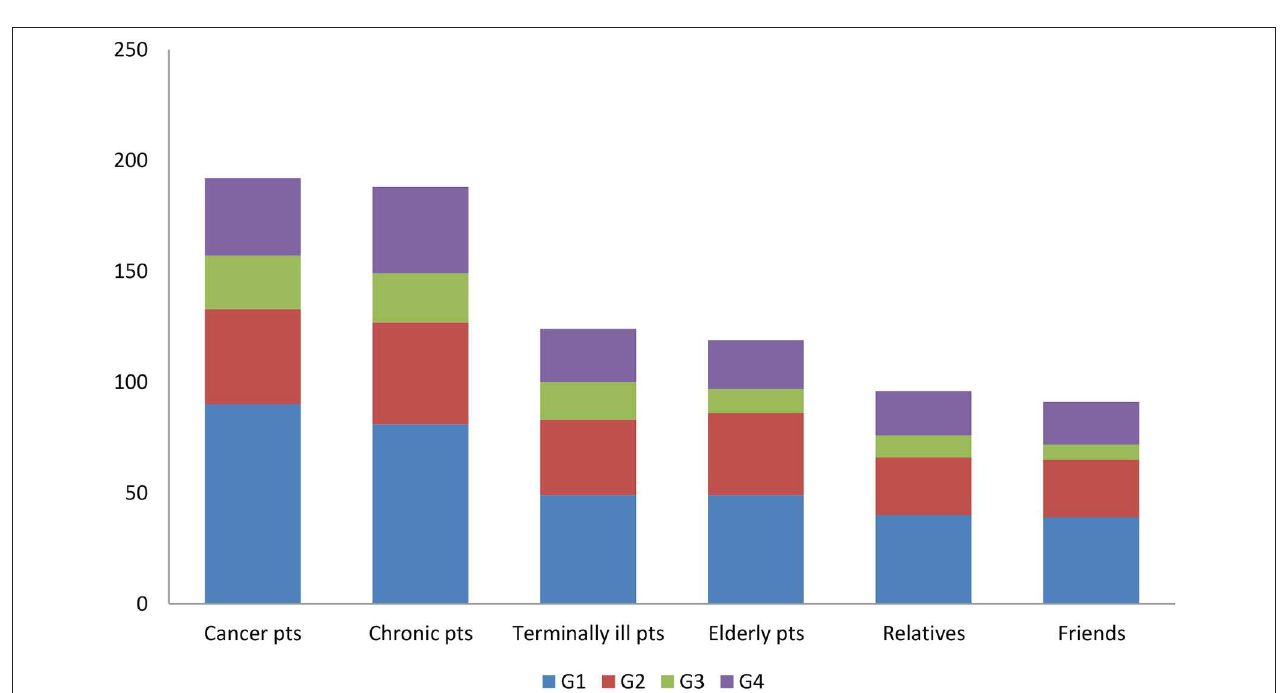
FIGURE 1 | Type of CAM interventions known to participants in relation to specialty group.